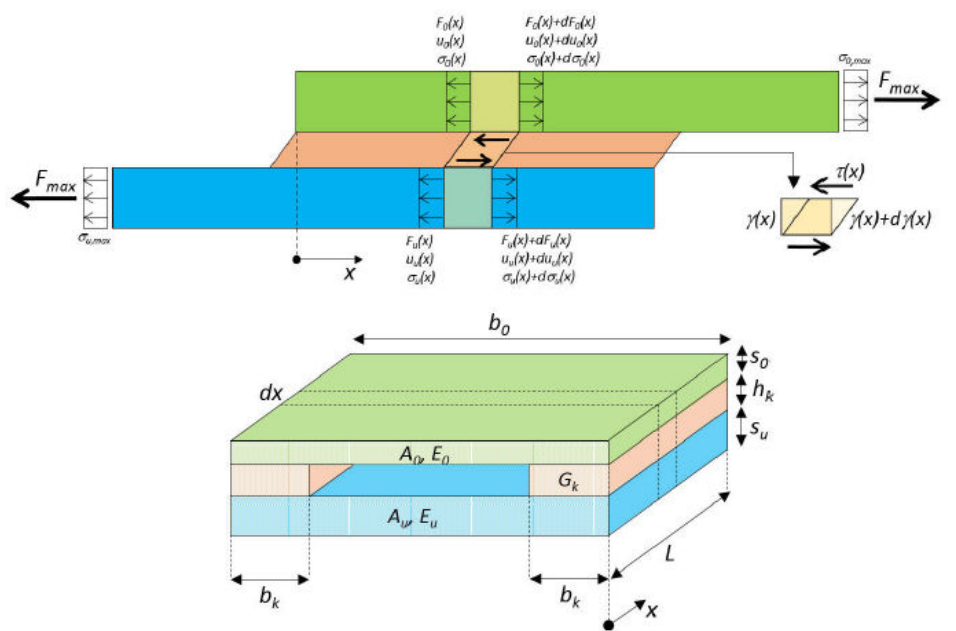
Figure 13. Mechanical model for the analysis of force transmission and deformation behaviour in BiR